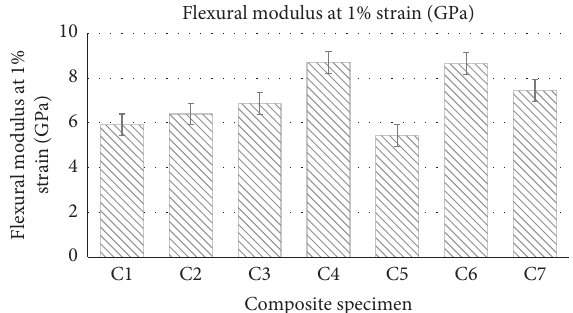
Figure 6: Flexural modulus of hybrid and nonhybrid composites at 1% strain.